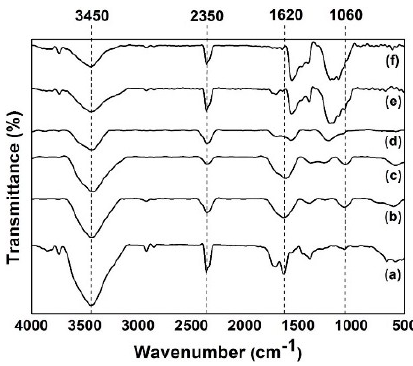
Figure 6. FT-IR spectra of ( a ) GO; GO electrochemically reduced at ( b ) 5 V; ( c ) 10 V; ( d ) 15 V; ( e ) 20 V; and ( f ) 25 V.